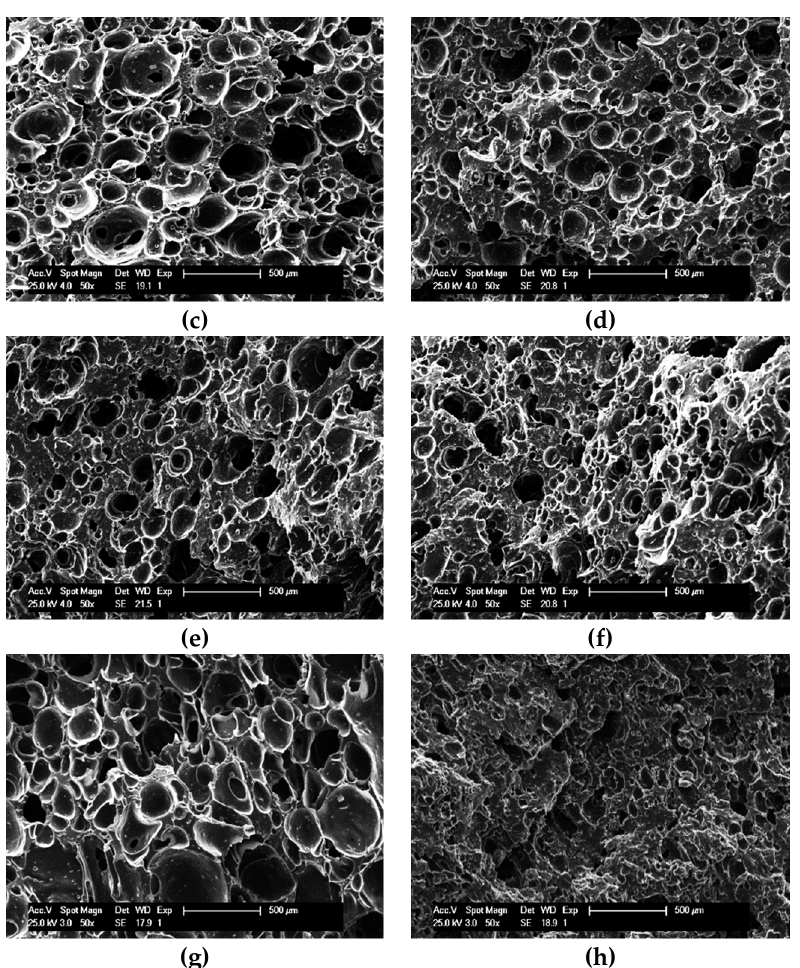
Figure 2. SEM micrographs of cryo-fractured surfaced foamed nanocomposites: ( a ) B20C0, ( b ) B20C2, ( c ) B20C4, ( d ) B20C6, ( e ) B20C8, ( f ) B20C10, ( g ) B0C2, and ( h ) B0C10.